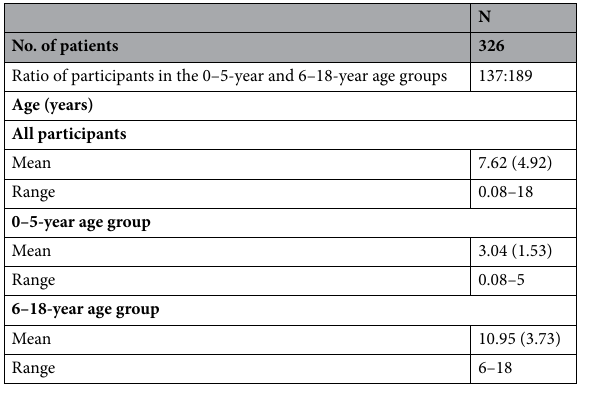
Table 1. Characteristics of the study